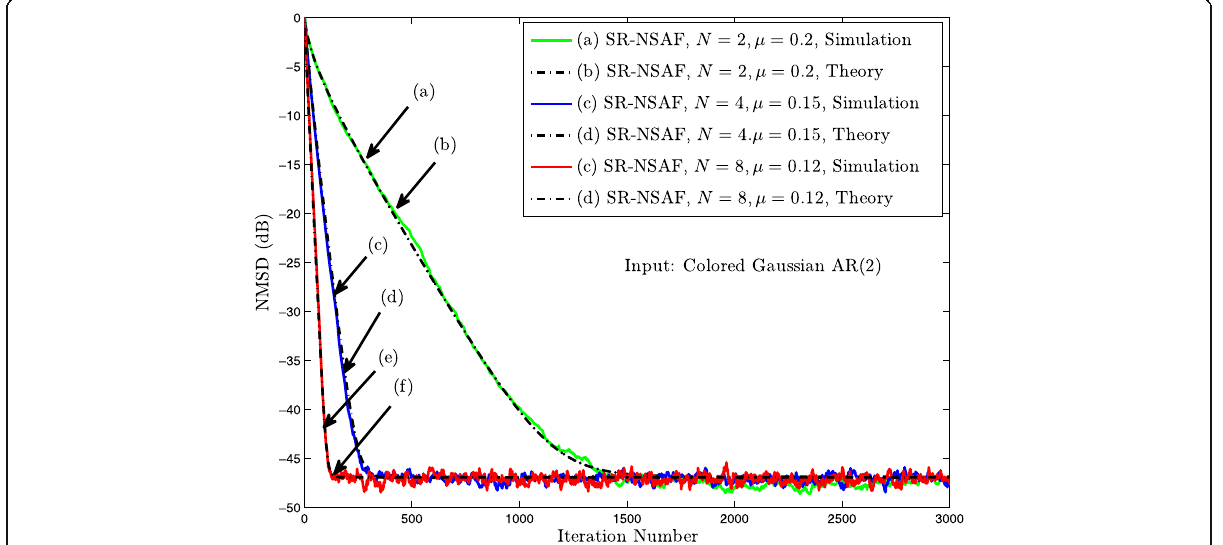
Fig. 21 Simulated and theoretical NMSD learning curves of SR-NSAF for different values of N